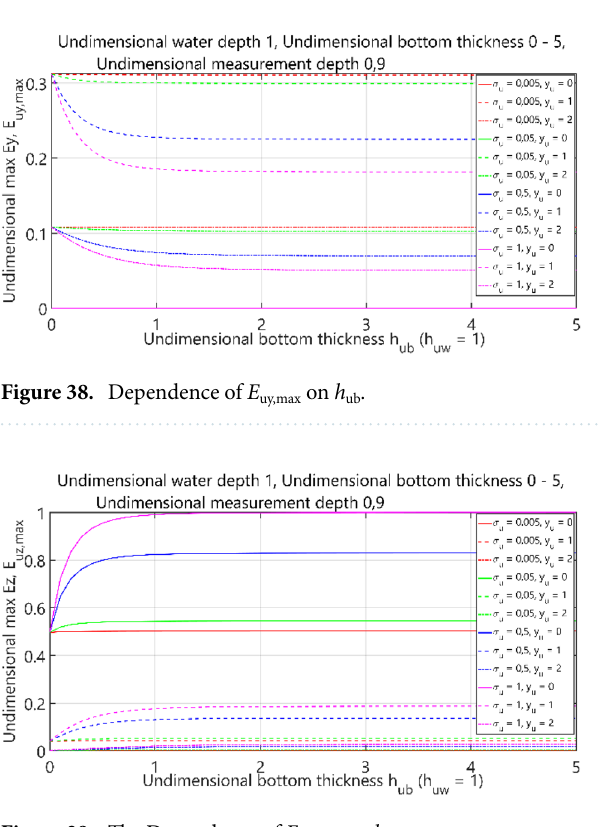
Figure 39. The Dependence of E uz,max on h ub